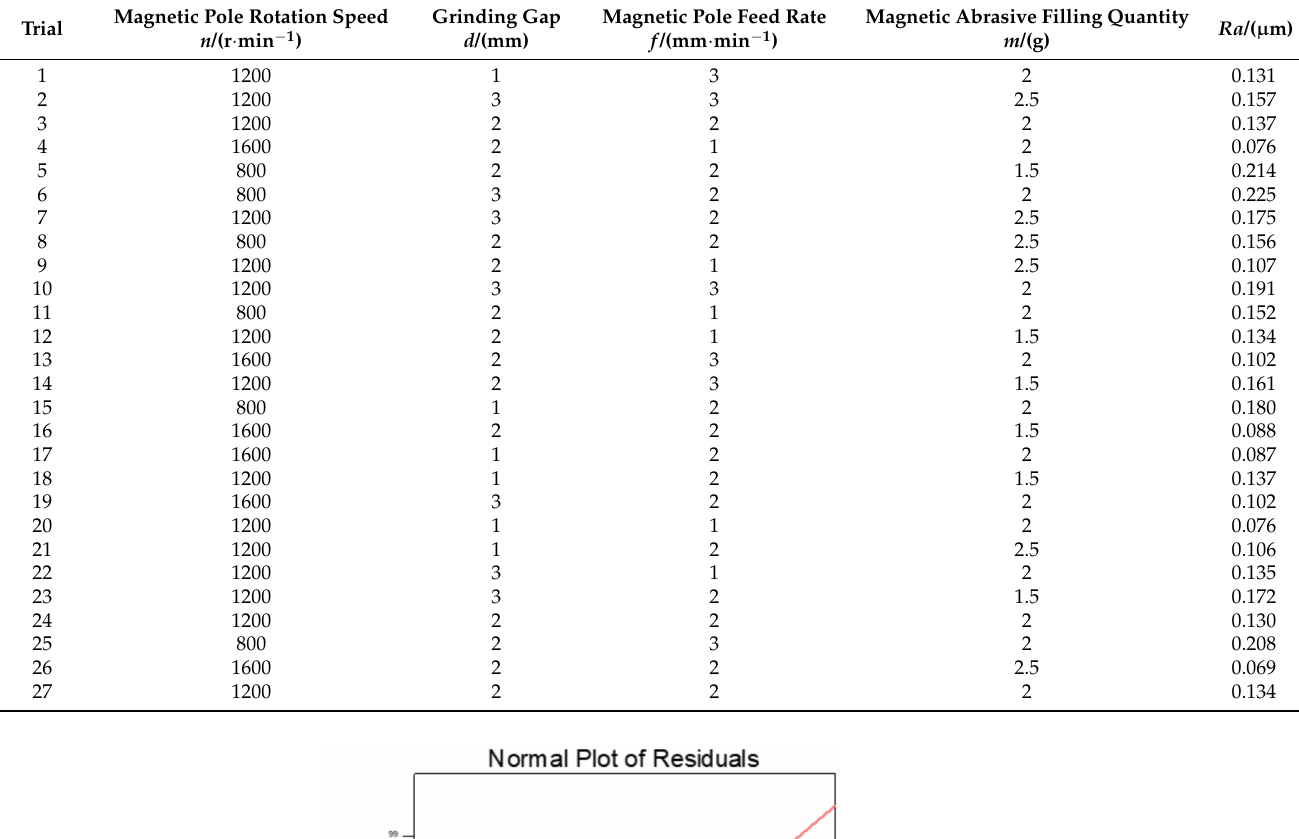
Table 4. Response surface experimental dataset.